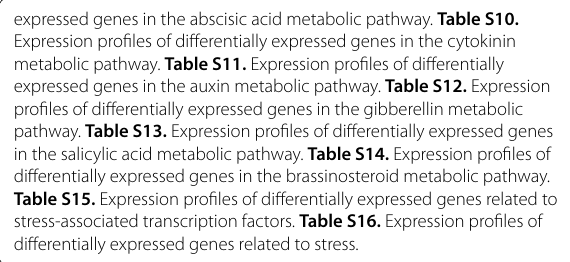
metabolic pathway. Table S11. Expression profiles of differentially expressed genes in the auxin metabolic pathway. Table S12. Expression profiles of differentially expressed genes in the gibberellin metabolic pathway. Table S13. Expression profiles of differentially expressed genes in the salicylic acid metabolic pathway. Table S14. Expression profiles of differentially expressed genes in the brassinosteroid metabolic pathway. Table S15. Expression profiles of differentially expressed genes related to stress-associated transcription factors. Table S16. Expression profiles of differentially expressed genes related to stress.